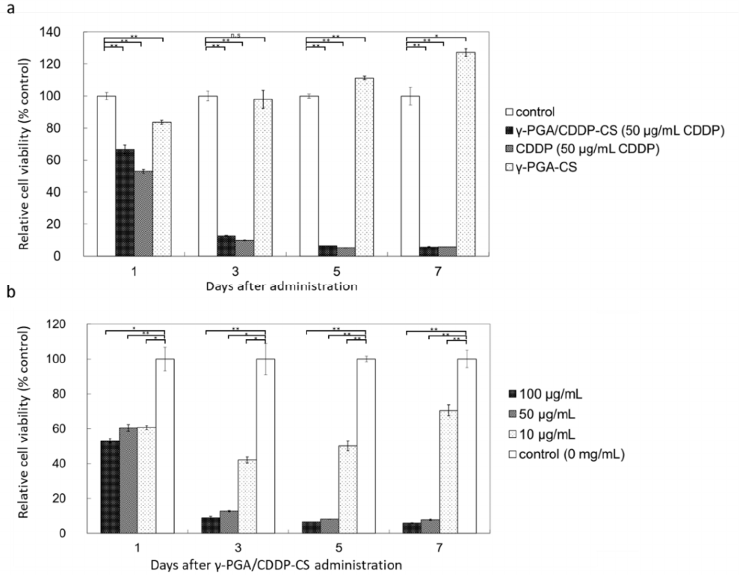
Figure 3. In vitro cytotoxicity of γ -PGA/CDDP-CS. ( a ) Relative cell viability compared with the con- trol: time-dependent cytotoxicity was observed for all compounds (50 µ g/mL CDDP), except γ -PGA- CS, which did not include CDDP. The values were 66.7% ± 2.7%, 53.0% ± 1.1%, and 83.7% ± 1.3% on Day 1; 12.7% ± 0.4%, 9.8% ± 0.2%, and 98.0% ± 5.6% on Day 3; 6.4% ± 0.1%, 4.7% ± 0.2%, and 111.2% ± 1.1% on Day 5; and 5.8% ± 3.4%, 5.0% ± 0.3%, and 127% ± 2.5% on Day 7 for γ - PGA/CDDP-CS, CDDP, and γ -PGA-CS, respectively. ( b ) Relative cell viability of γ -PGA/CDDP-CS compared with the control at a concentration of 10 µ g/mL; cytotoxicity was slightly lower than that at 50 µ g/mL and 100 µ g/mL. The values for 100, 50, and 10 µ g/mL of γ -PGA/CDDP-CS were 53.1% ± 1.2%, 60.4% ± 1.9%, and 60.7% ± 1.1% on Day 1; 9.1% ± 0.8%, 12.7% ± 0.4%, and 42.1% ± 1.7% on Day 3; 6.5% ± 0.0%, 8.1% ± 0.1%, and 50.2% ± 2.8% on Day 5; and 5.8% ± 0.2%, 7.7% ± 0.4%, and 70.4% ± 3.2% on Day 7, respectively. Data are represented as mean values ± stan- dard error of the mean (SEM). Significant differences were analyzed by t-test (* p < 0.05, ** p < 0.01, n.s: Not